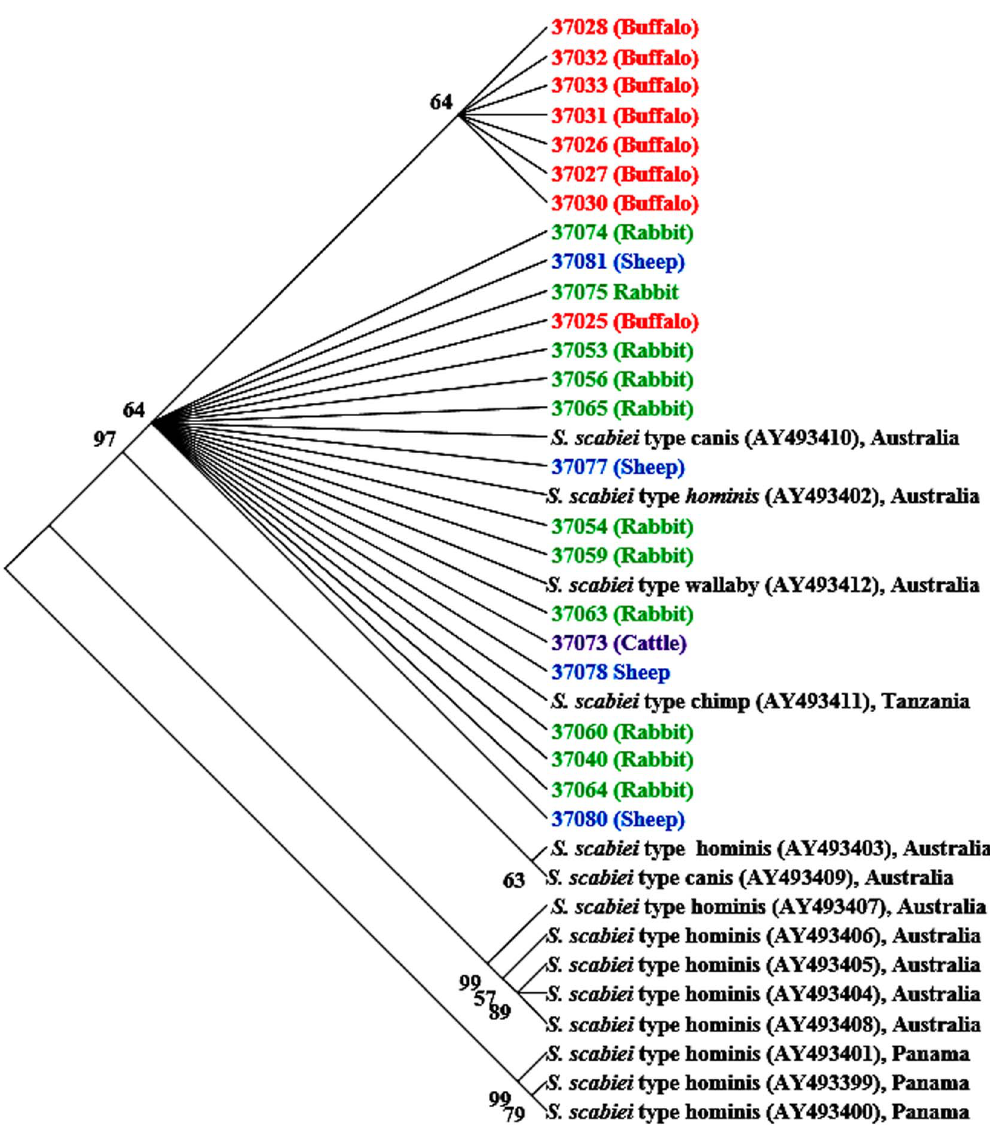
Figure 3. Un-rooted NJ tree of showing genetic relationship of Egyptian Sarcoptes mites to others in the GenBank database based on mitochondrial 16S rRNA sequences. Evolutionary relationships of 38 taxa were inferred using the neighbor-joining [46]. Numbers at the internodes correspond to percent bootstrap values from 2,000 replicates. Branches corresponding to partitions produced in less than 50% bootstrap replicates are collapsed. Sequences in bolded colors and with no GenBank accession numbers are generated from Egyptian specimens.